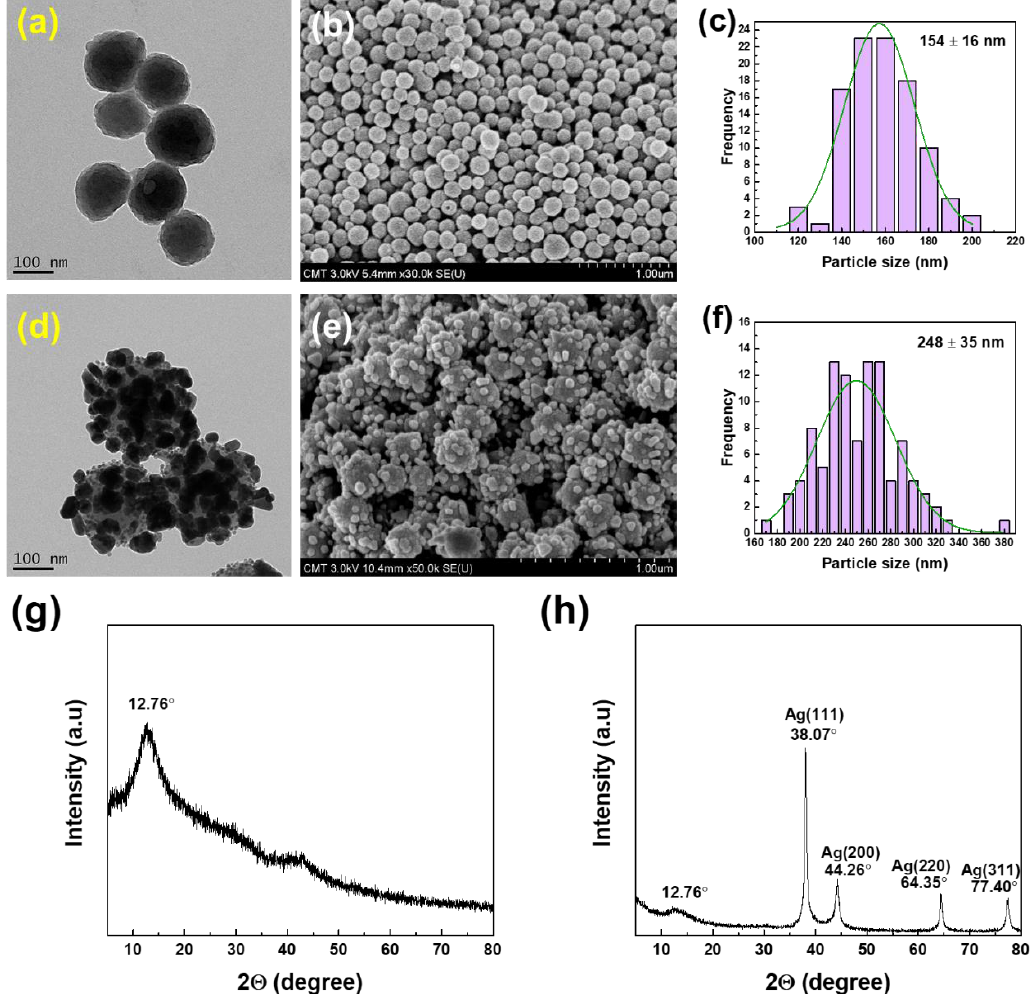
Figure 2. TEM and FESEM images, size distribution, and XRD spectra of ( a – c , g ) PDA and ( d – f , h ) Ag-PDA particles.